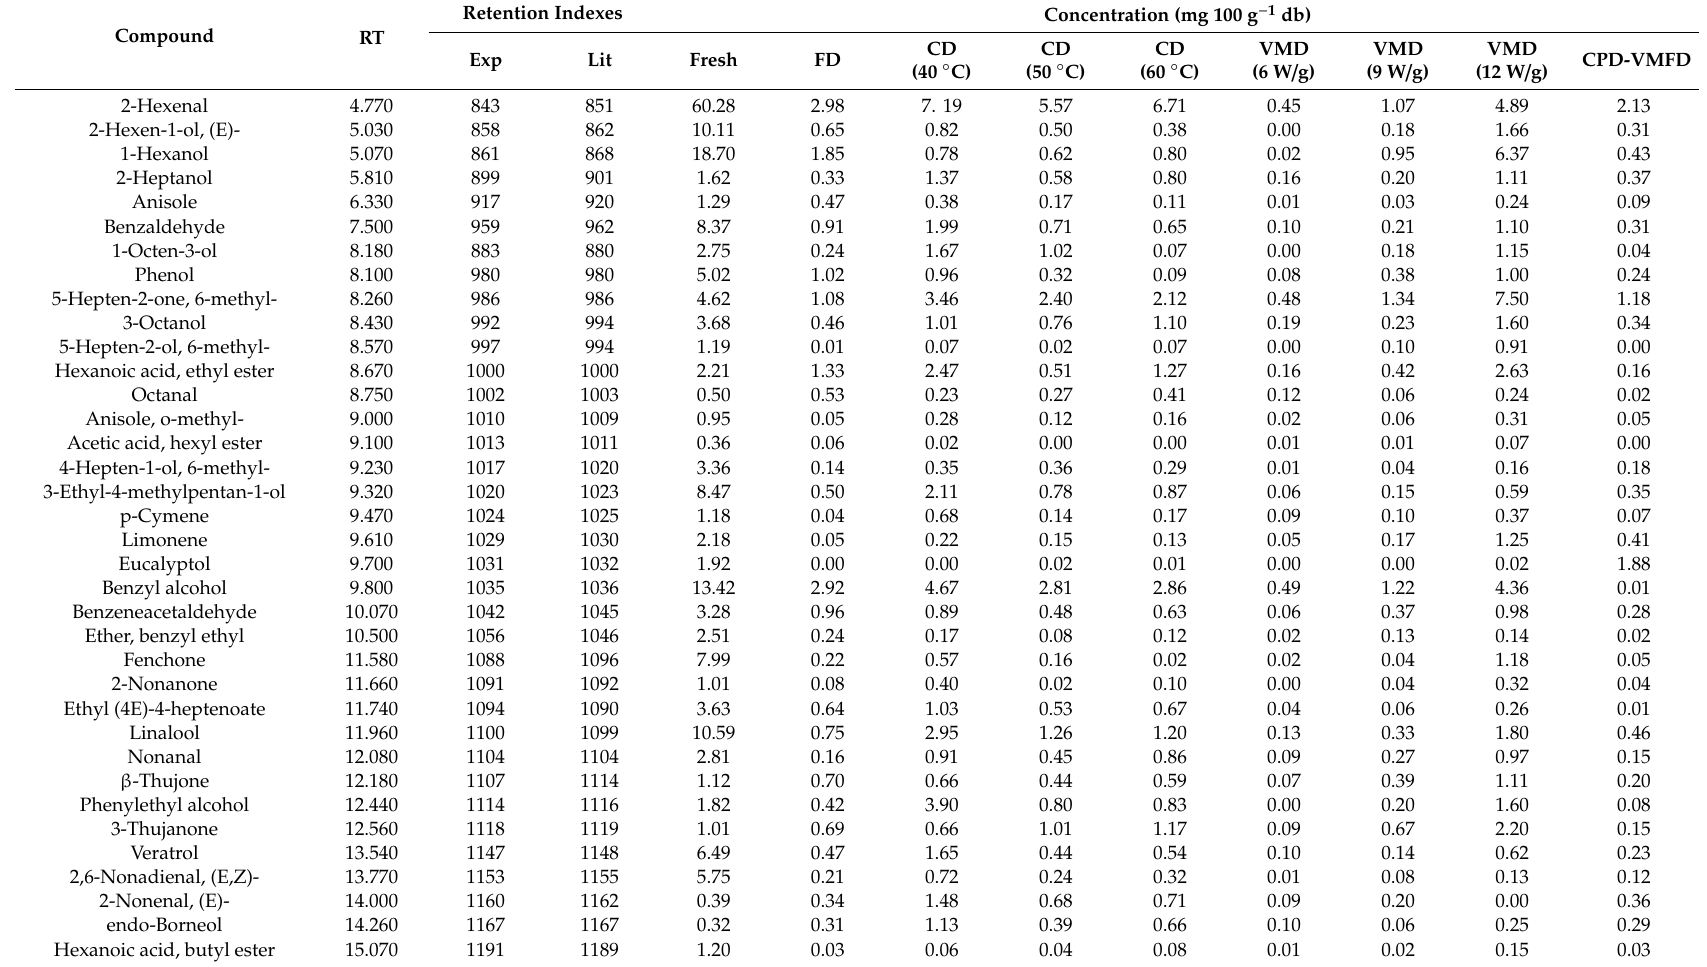
Table 4. Concentration of volatile compounds influenced by various drying methods and